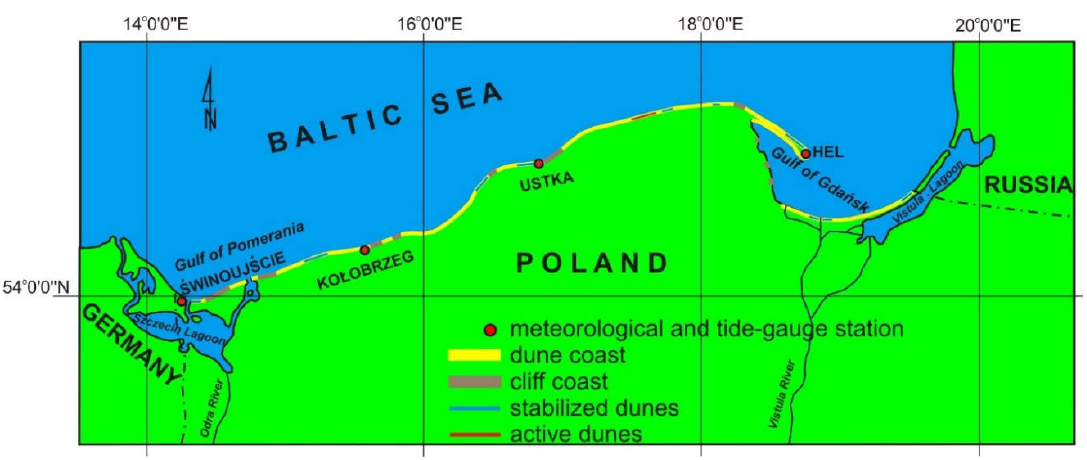
Figure 1. Area of research—location of measurement stations in the Polish Baltic coastal zone.